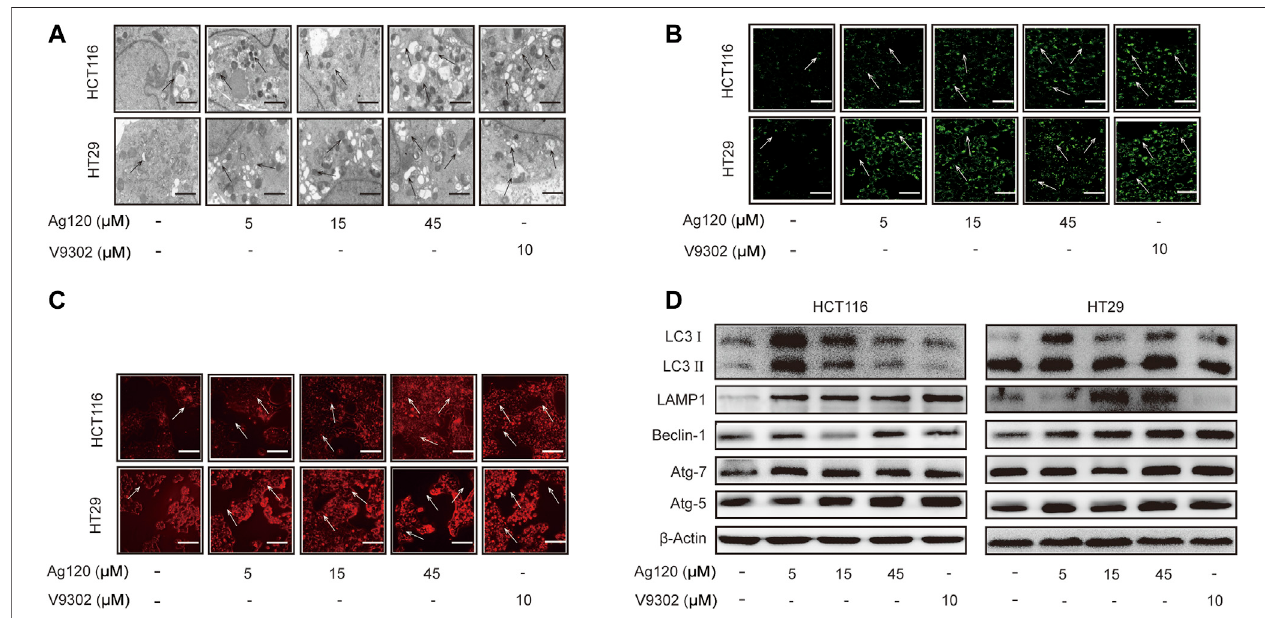
FIGURE 3 | Ag120 induces autophagy in CRC cells. (A) Transmission electron microscopy images of HCT116 cells treated with AG120 or V9302 for 72 h. Scale bars, 1 µm. (B,C) Fluorescence microscopy images of CRC cells incubated with Ag120 or V9302 for 72 h and labeled with MDC to visualize autophagic vesicles (B) or with LysoTracker to visualize lysosomes (C) . Scale bars, 50 µm. (D) Immunoblot analysis of LC3, LAMP1, beclin-1, ATG7, and ATG5 expression in CRC cells treated with Ag120 or V9302 for 72